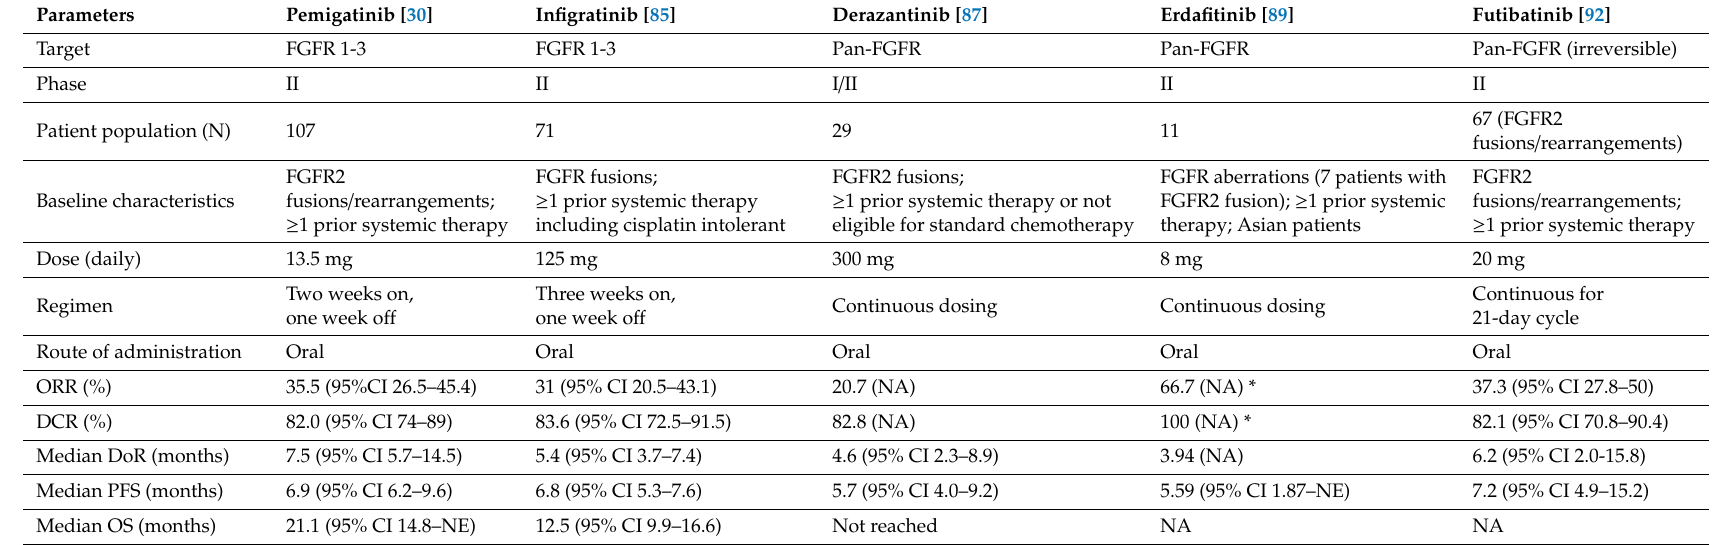
Table 1. E ffi cacy results of FGFR inhibitors in intrahepatic cholangiocarcinoma harboring FGFR